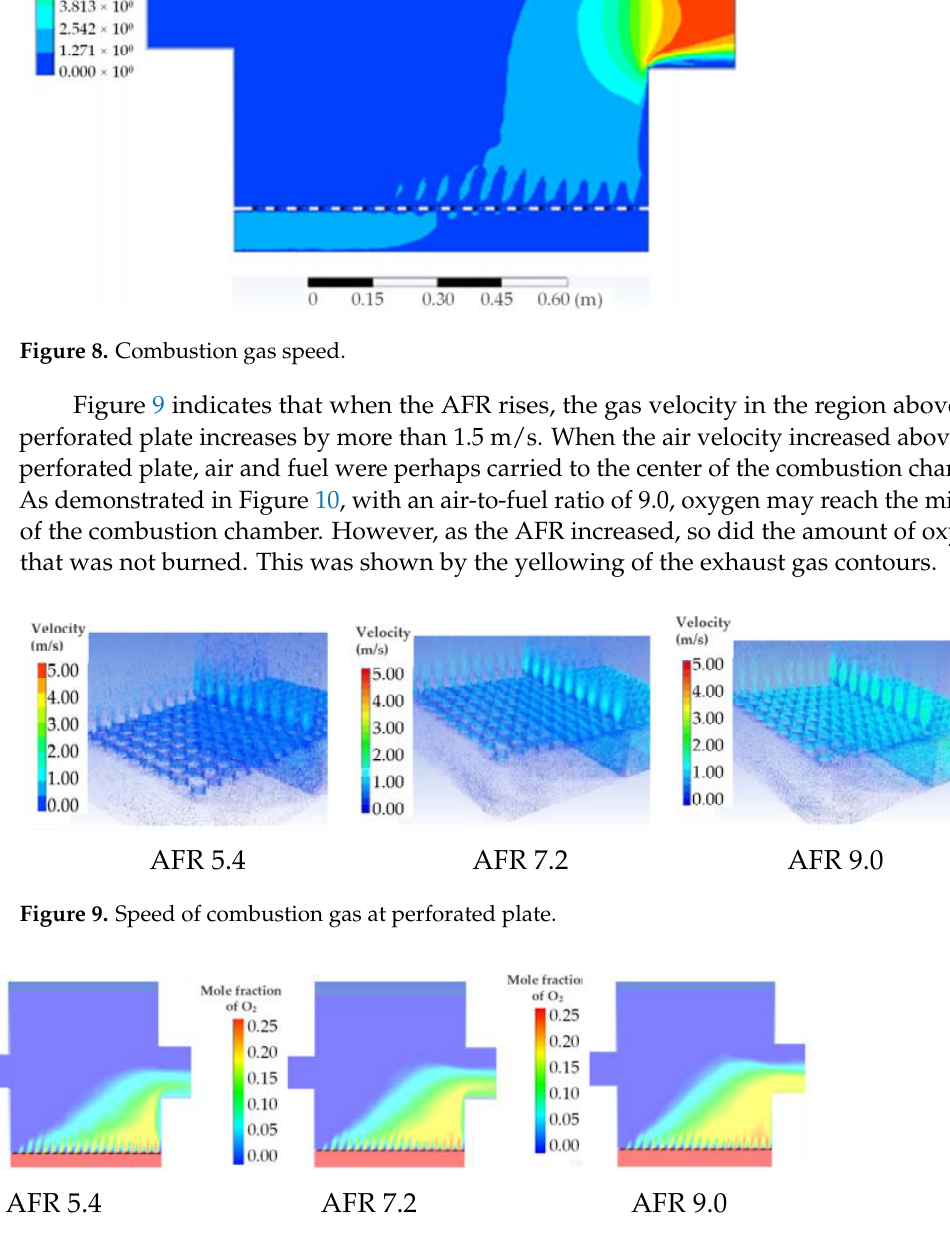
Figure 10. Contours of O 2 concentration.